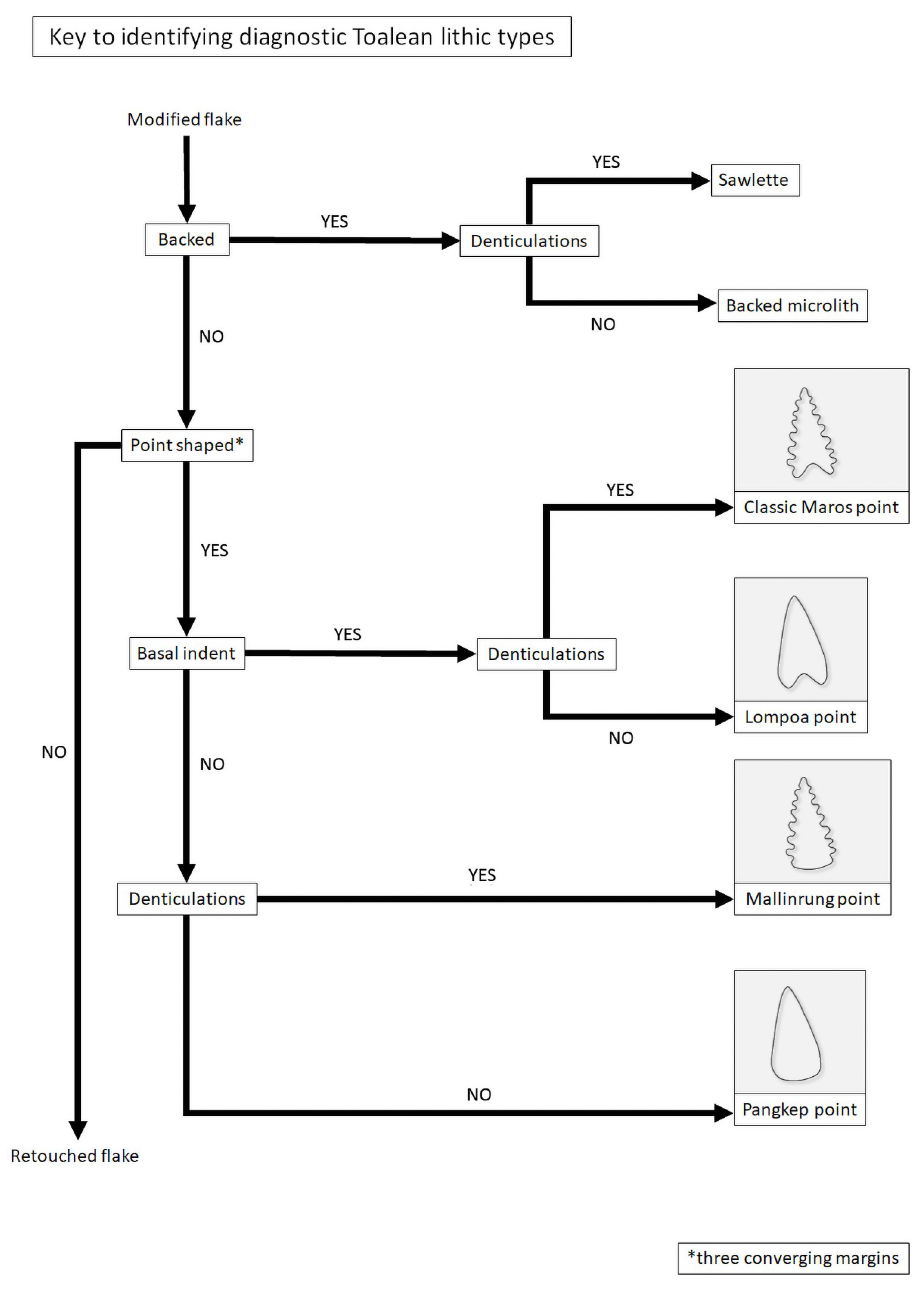
Fig 13. Key for identifying the defining Toalean lithic